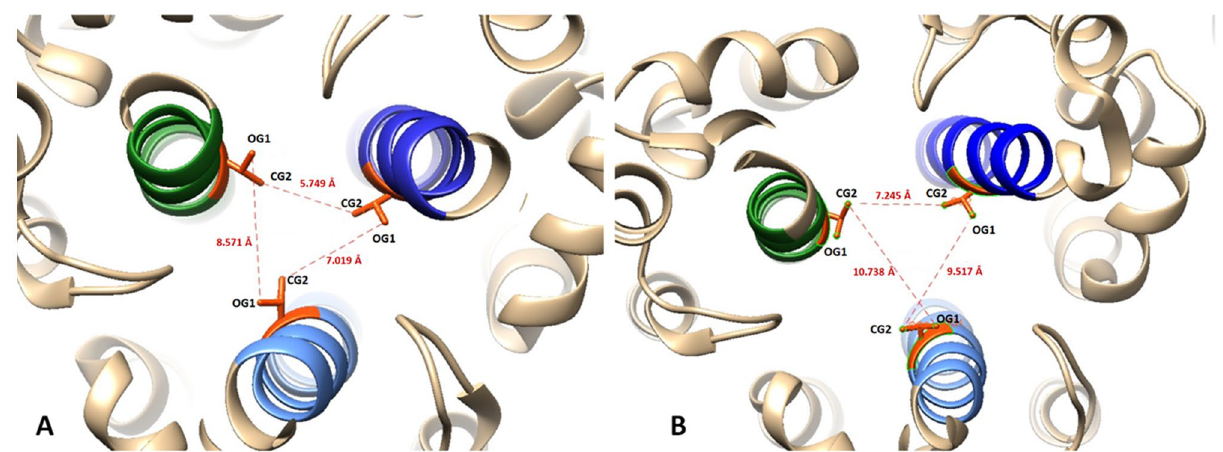
Figure 3. Distances between OG1 and CG2 of the monomers A (green), B (blue), and C (light blue) of THR 988 in Spike protein. We observed that there is a slight increase in distance suggesting that these helices could separate from each other once the membrane fusion process begins. In ( A ) the closed conformation is observed (smaller distances) and in ( B ) the open conformation. With the presence of UDCA, it remains in a conformation similar to ( A ). Taken from 7DF3.pdb and 7BNO.pdb and edited with chimera V.